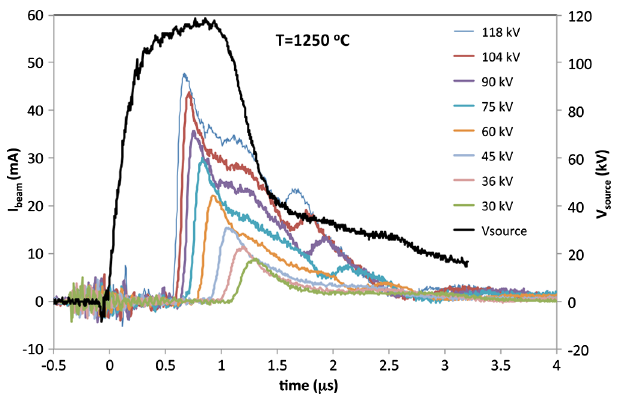
FIG. 7. WARP simulation of the beam current (blue) with the empirically adjusted model described in the text is compared to ¼ 90 kV , T ¼ 1250 (cid:1) C ). The model the experiment (red, V s includes contributions from Li þ (black) and K þ